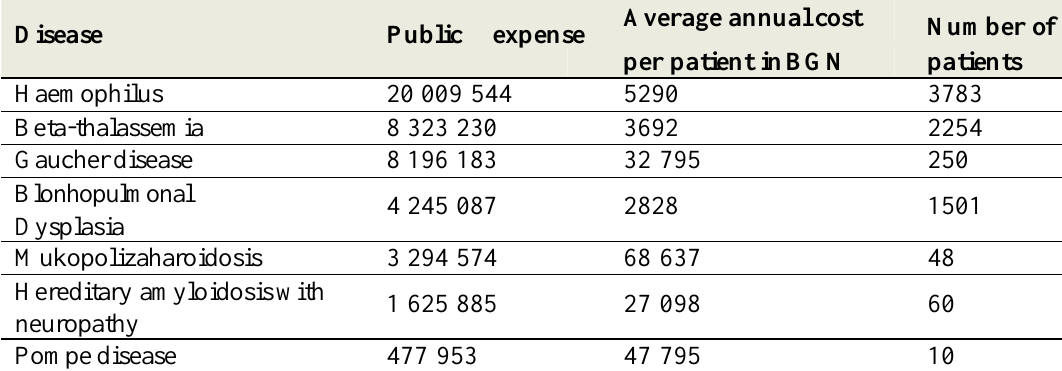
Table 1. Expenses for the treatment of rare diseases in2013 (Source: NHIF Report for June